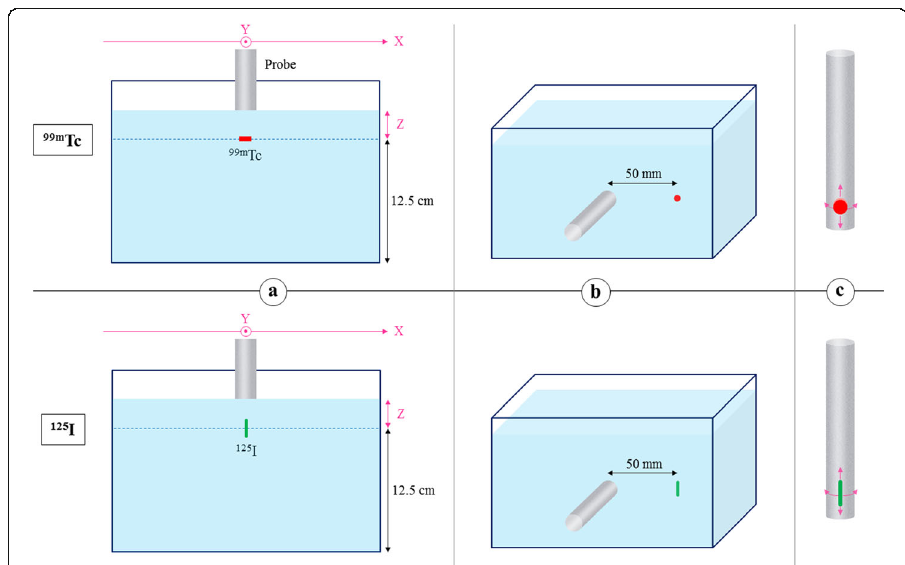
Fig. 2 Schematic representation of the count rate capability ( Z = 10 mm), sensitivity ( Z = 10, 30 and 40 mm) and spatial resolution ( Z = 10, 20 and 30 mm) in a scatter medium ( a ), sensitivity to scatter ( b ) and side and back shielding ( c ) tests with a 99m Tc source and a 125 I-seed. For the sensitivity in air ( Z = 0, 10, 30 and 50 mm) and sensitivity through side shielding in air assessments, a and b setups were respectively used without water. The probe was slided through the X axis for the spatial resolution test; it was fixed at X = 0 mm for every other